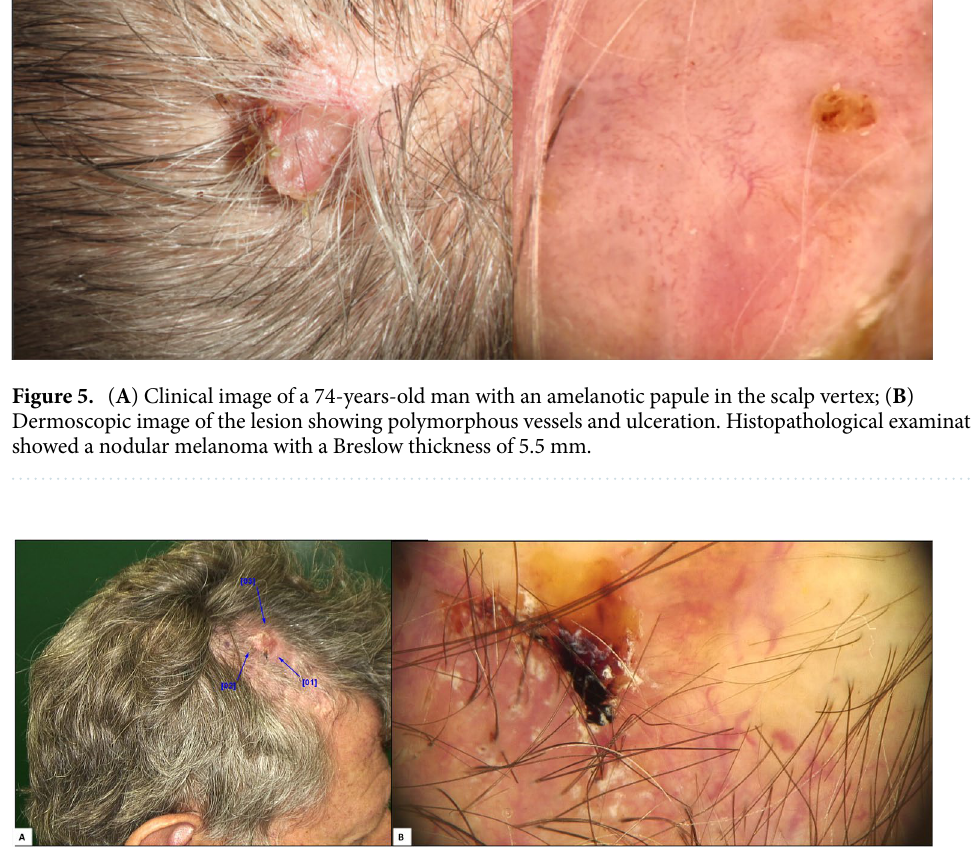
Figure 6. ( A ) Clinical image of a 71-years-old man with a poorly delimited amelanotic plaque; ( B ) Dermoscopic image of the lesion showing polymorphous vessels and ulceration. Histopathological examination showed a desmoplastic melanoma throughout the entire skin thickness and invasion of the skull on